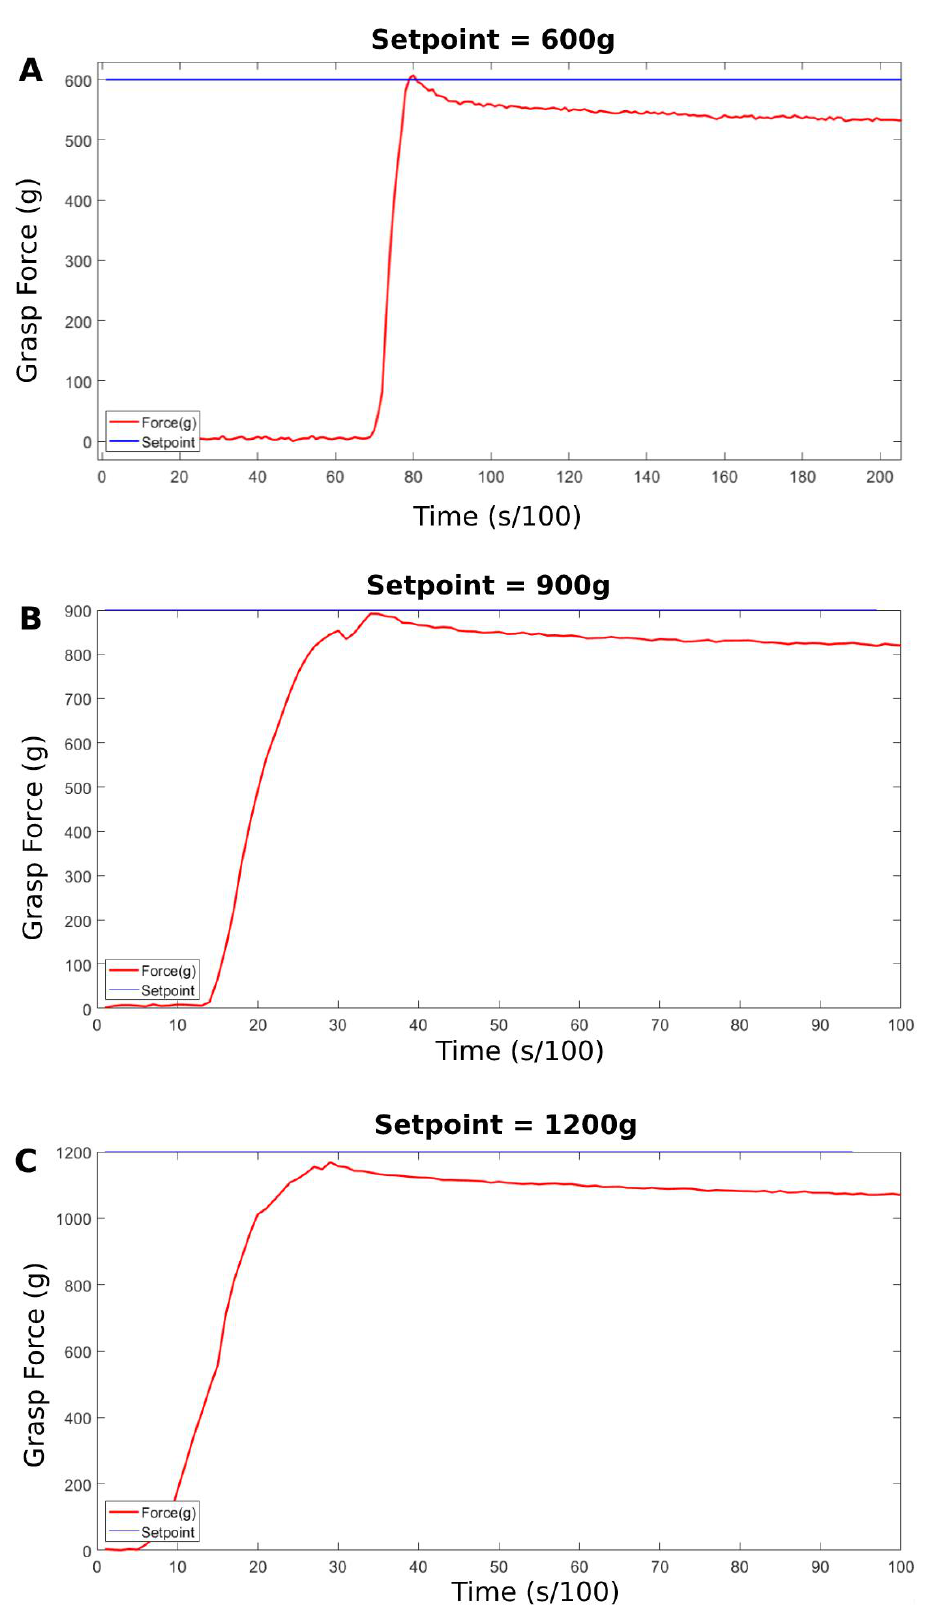
Figure 13. Sample graphs of the recorded responses for setpoints of ( A ) 600 g, ( B ) 900 g, and ( C ) 1200 g.